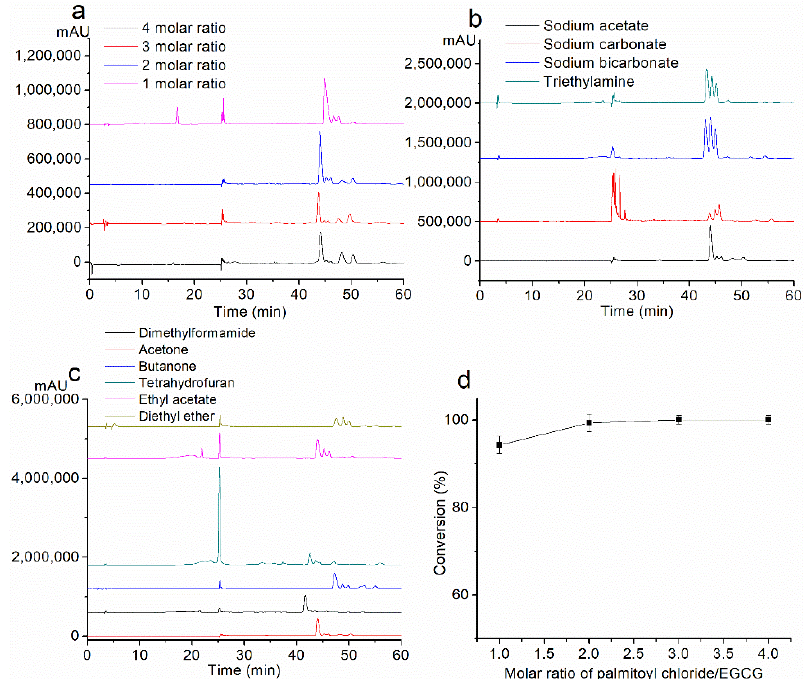
Figure 1. Effect of ( a ) molar ratio of palmitoyl chloride, ( b ) base, and ( c ) solvent, on the effect of the reaction by HPLC analysis. ( d ) EGCG conversion under the condition of 1–4 molar ratios of palmitoyl chloride. Table 3. Effect of the base on the acylation reaction.